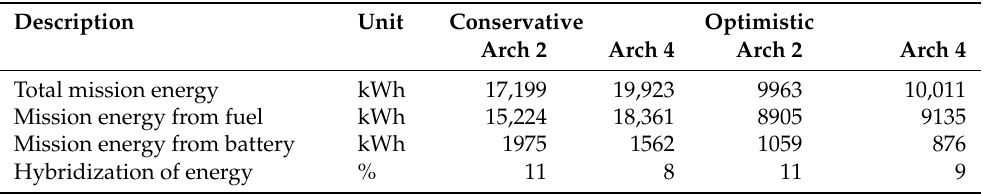
Table 9. Results on energy from the initial sizing for Architectures 2 and 4.